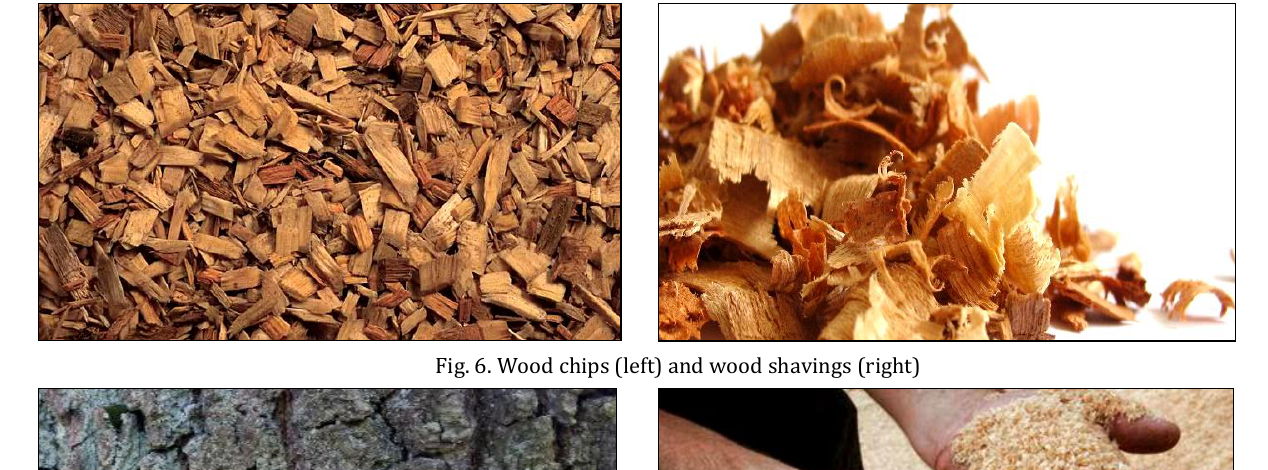
Fig. 6. Wood chips (left) and wood shavings (right)